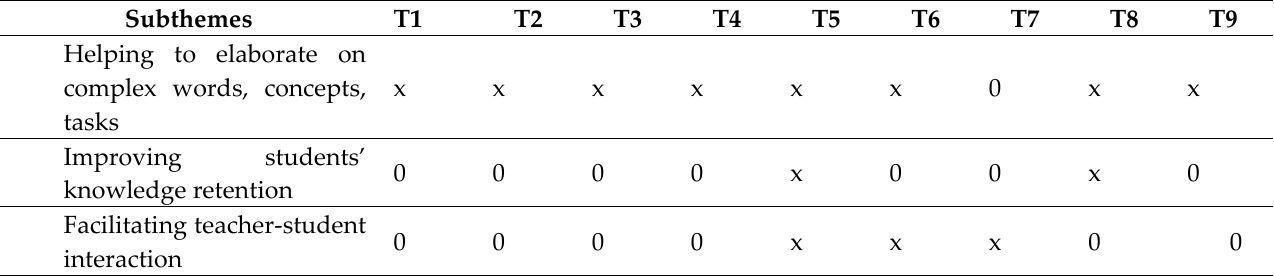
Table 4. Facilitating Role of